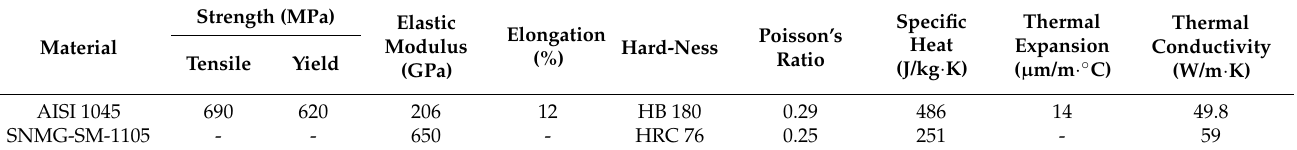
Table 1. Mechanical and thermal properties of the steel AISI 1045 steel and carbide insert [59,60].